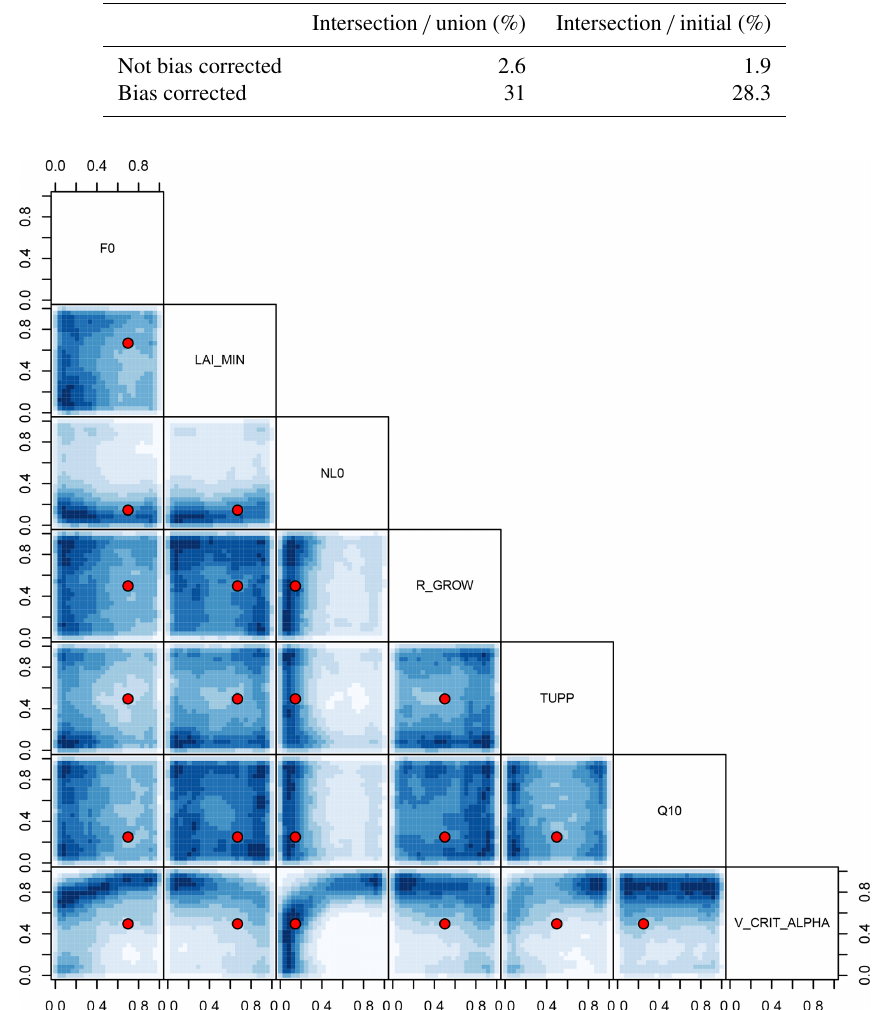
Table 3. Measures of the NROY input space shared by all three forests. The intersection is NROY for all three forests, the union is NROY for at least one forest. The initial space is that defined by the parameter limits of the initial experiment design.